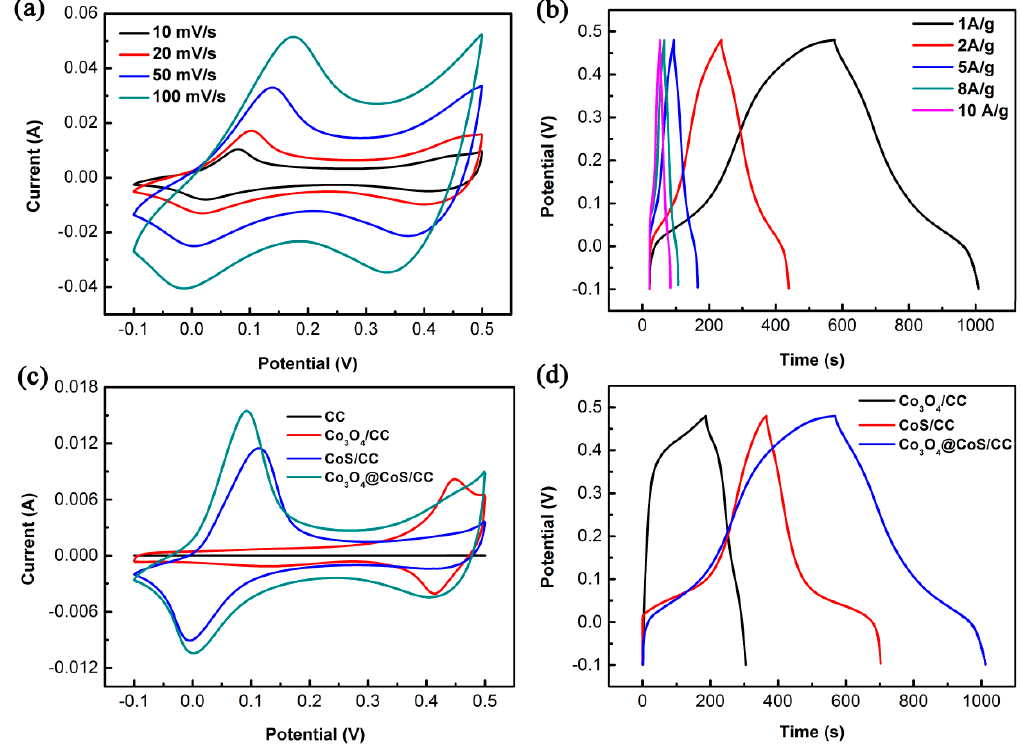
Figure 6. ( a ) CV curves of Co 3 O 4 @CoS/CC at different scan rates; ( b ) Galvanostatic charge/discharge curves of Co 3 O 4 @CoS/CC at different current densities; ( c ) CV curves of CC, Co 3 O 4 /CC, CoS/CC and Co 3 O 4 @CoS/CC at 10 mV·s − 1 ; ( d ) Galvanostatic charge/discharge curves of Co 3 O 4 /CC, CoS/CC and Co 3 O 4 @CoS/CC at 1.0 A·g − 1 .